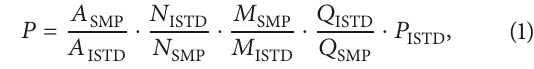
Table 1: Spectral widths of DMSO- d